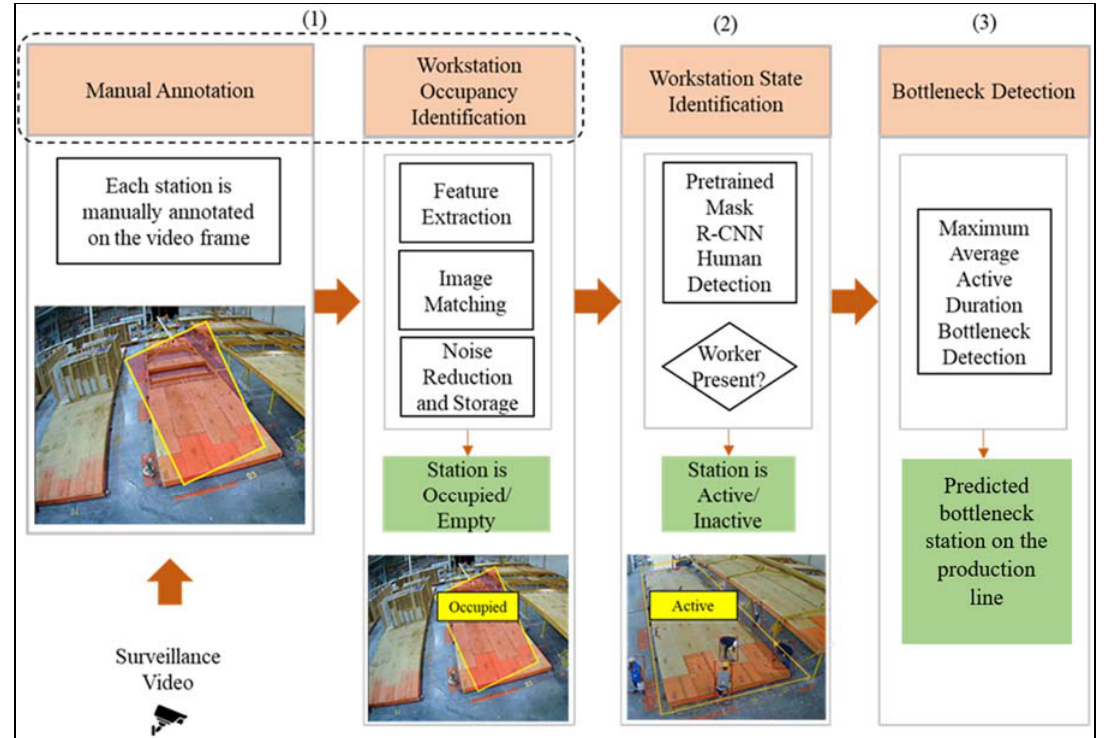
Figure 1. Proposed progress monitoring and bo tt leneck detection